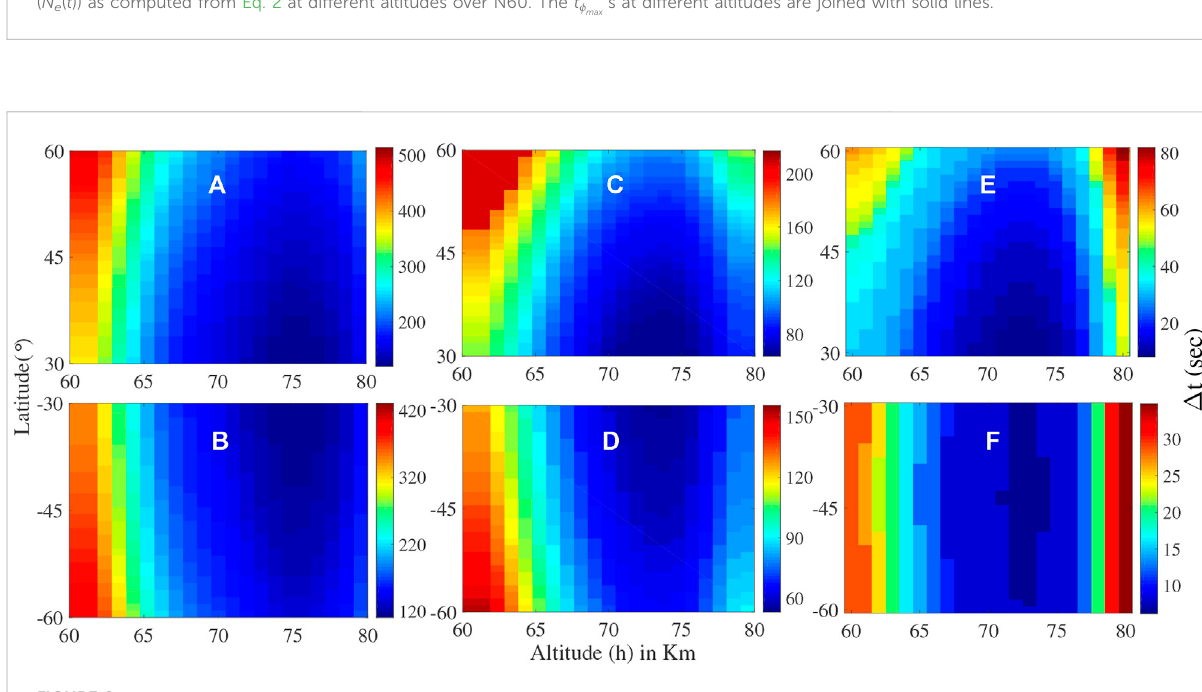
FIGURE 2 Latitudinal variation of Δ t - h pro fi le of (A,B) C5.2, (C,D) M5.2 and (E,F) X2.2 classes of solar fl